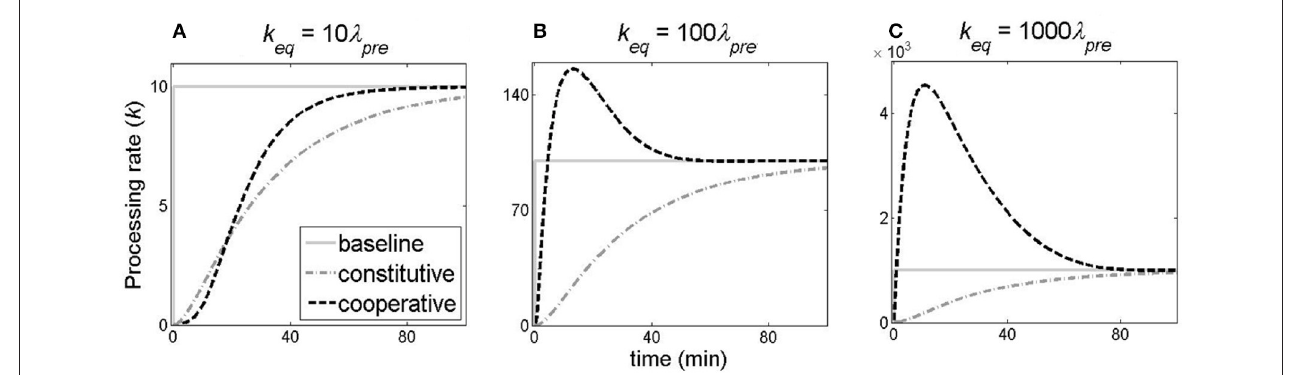
FIGURE 6 | Comparing the dynamics of the pre-crRNA processing rate change. The change of the processing rate k with time is shown for: the baseline model (solid gray curve), the constitutive model (dash-dotted gray curve) and the cooperative model (dashed black curve). (A–C) correspond to different k eq values ( k eq = 10 λ pre ,